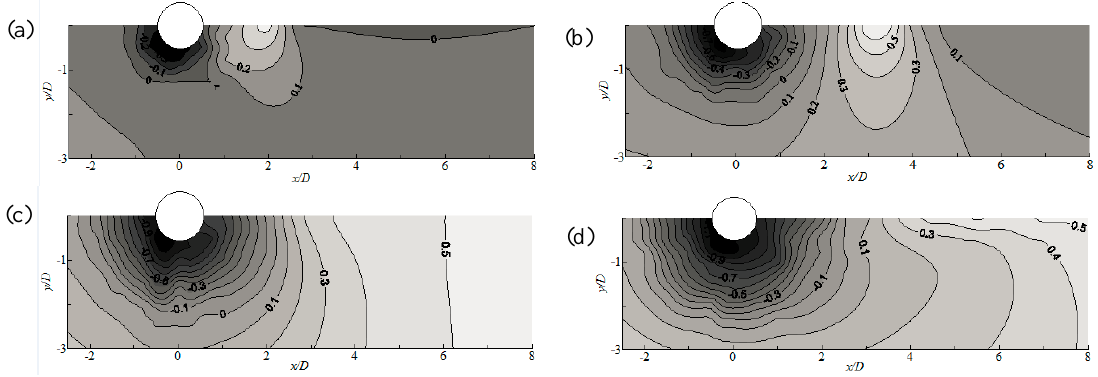
Figure 3. Scour morphology around the pier at the time of ( a ) t* = 11; ( b ) t* = 133; ( c ) t* = 266; and ( d ) t* = 931.